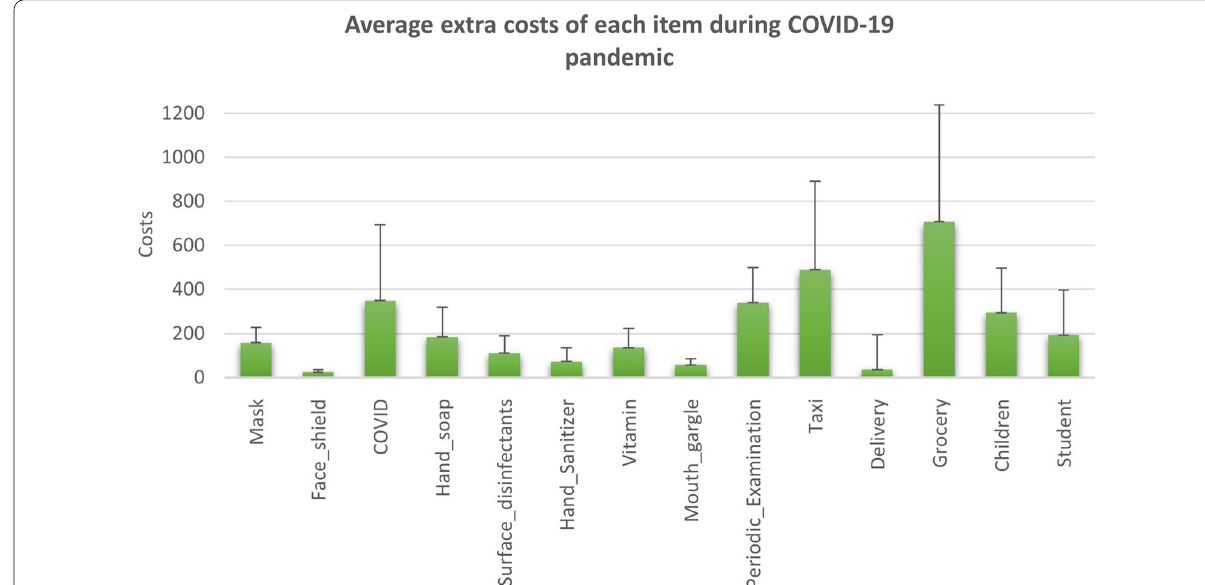
Fig. 1 Average extra costs of each item during COVID-19 pandemic